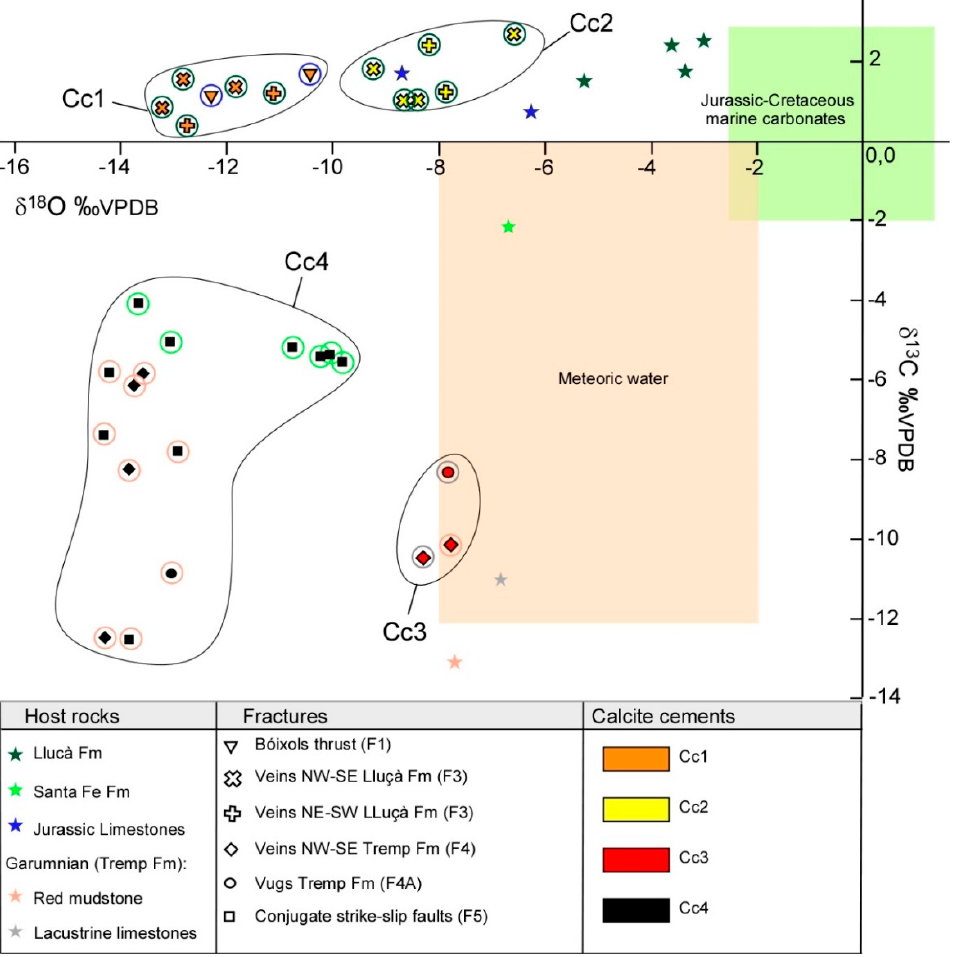
Figure 11. δ 18 O vs δ 13 C cross-plot of carbonate host rocks and calcite cements. Stars represent host rocks, other symbols represent different fracture sets, colors of symbols represent cement generations and the color of the circles englobing fracture symbols represent the associated host rocks. Meteoric water range of values is from Reference [90] and Jurassic-Cretaceous marine carbonate values from Reference [91].